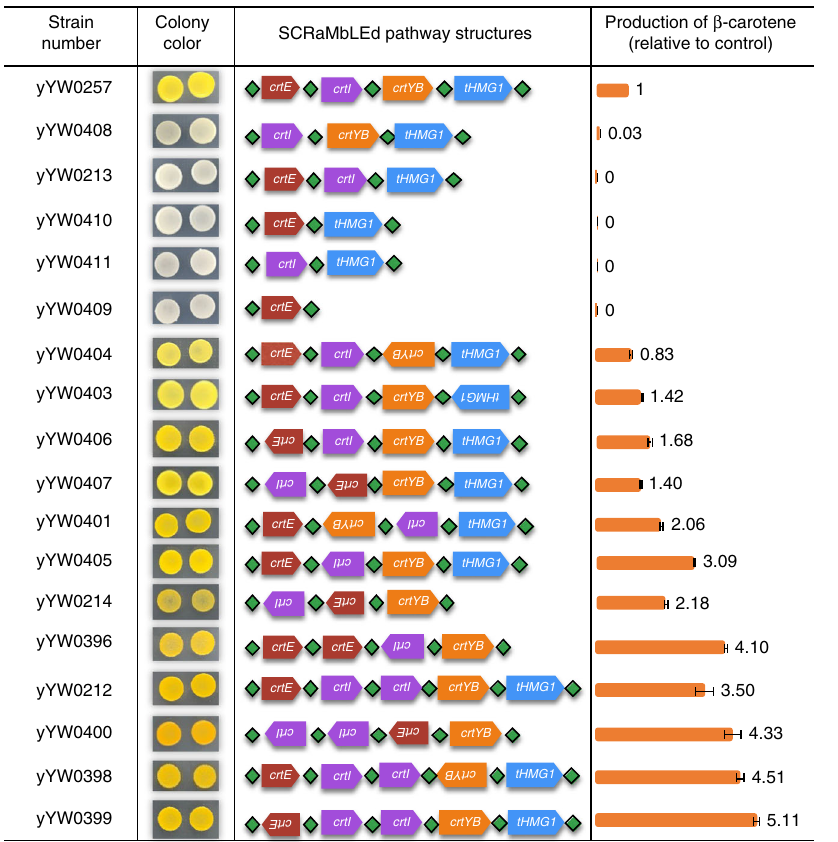
Fig. 2 Genotype – phenotype analysis of top-down in vitro SCRaMbLEd strains. The colony pictures were taken after 3 days incubation on SC – Ura medium. Strains derive from the experiment in Fig. 1f. The pathway structures of 17 SCRaMbLEd strains were veri fi ed by PCR analysis (Supplementary Fig. 6) and Sanger sequencing of the recovered yeast plasmids. The production of β -carotene was determined by high-performance liquid chromatography (HPLC) (Supplementary Fig. 7). Error bars represent standard deviation from three